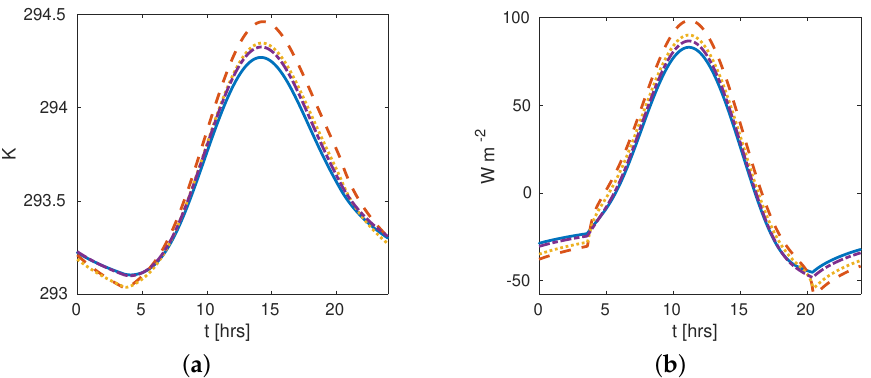
Figure 7. Temperature and heat balance in the soil, Cases 1 (solid), 2 (dashed), 3 (dotted), and 4 (dash-dot). In essence, the soil temperature and heat balance is the same for all the canopies, maximum values at midday and energy released at night. However, Cases 1 and 2 represent the extreme values from the rest of them. ( a ) Soil temperature (averaged in width); ( b ) Energy